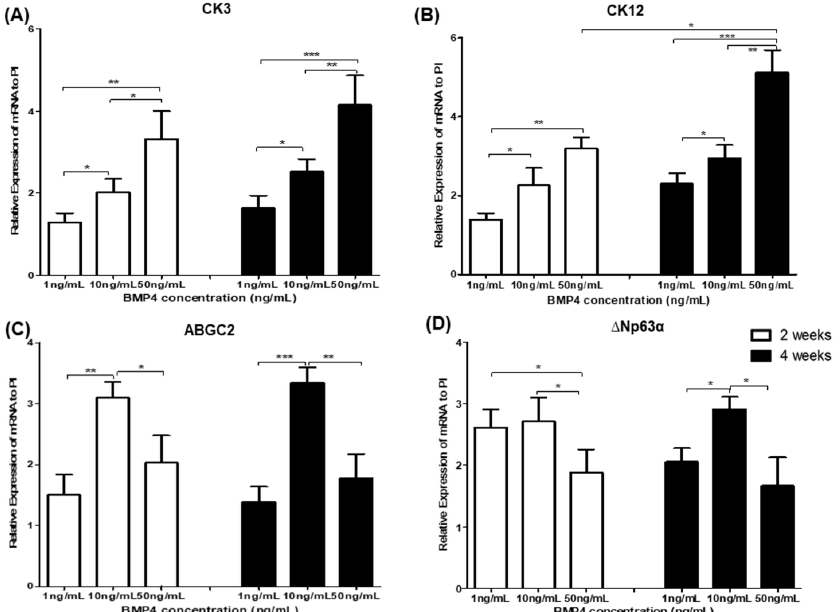
Figure 1. Analysis of gene expression for corneal epithelium markers ( A , B ) and limbal progenitor-related markers ( C , D ) in human iPS cells grown in a limbal cell culture system with varying doses of BMP4. Human iPS cells were harvested and seeded on fibronectin and laminin-coated dishes with a limbal-specific medium (PI). BMP4 (1, 10, and 50 ng/mL) was present for the first three days of culture. Data represent 3 or 4 independent experiments and are presented as means ± standard deviation (* p < 0.05; ** p < 0.001; *** p < 0.001). 3.2. Limbal Progenitors Differentiation from Human iPS Cells in Different Durations of BMP4 Treatment Curr. Issues Mol. Biol. 2021 , 1 , FOR PEER REVIEW The differentiation of human iPS cells into corneal limbal progenitors after 1, 3, or 10 days of 10 ng/mL BMP4 treatment was evaluated at 2 and 4 weeks in PI medium (Figure